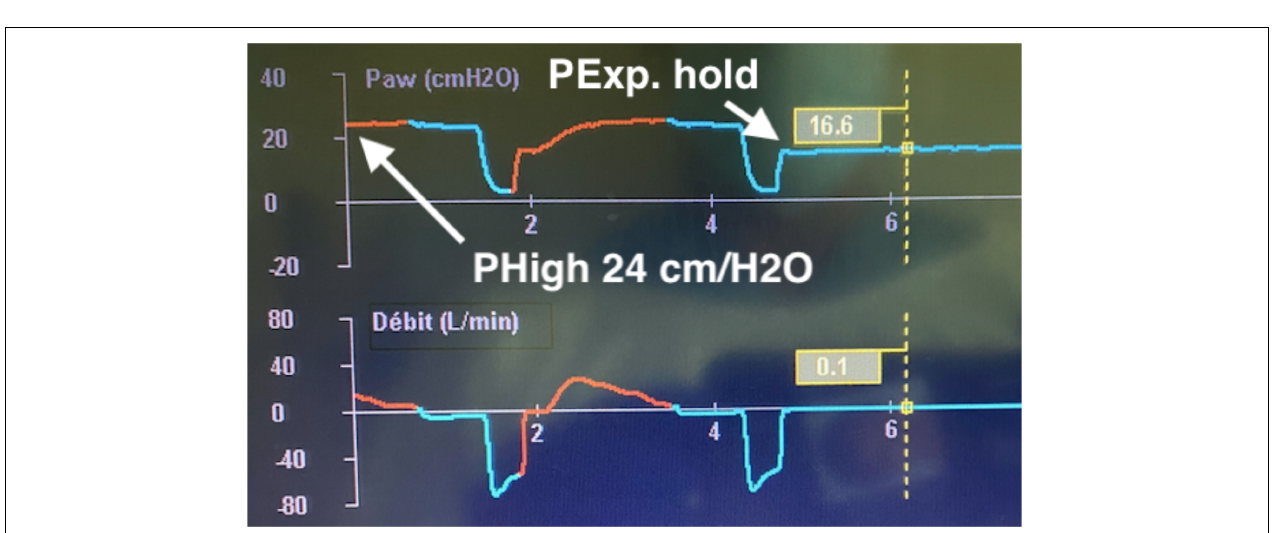
FIGURE 1 | Manual adjustment of TLow: peak expiratory flow is measured (left) and the TLow is set to obtain a cutoff at or above 75% of peak flow, in this case 77%.